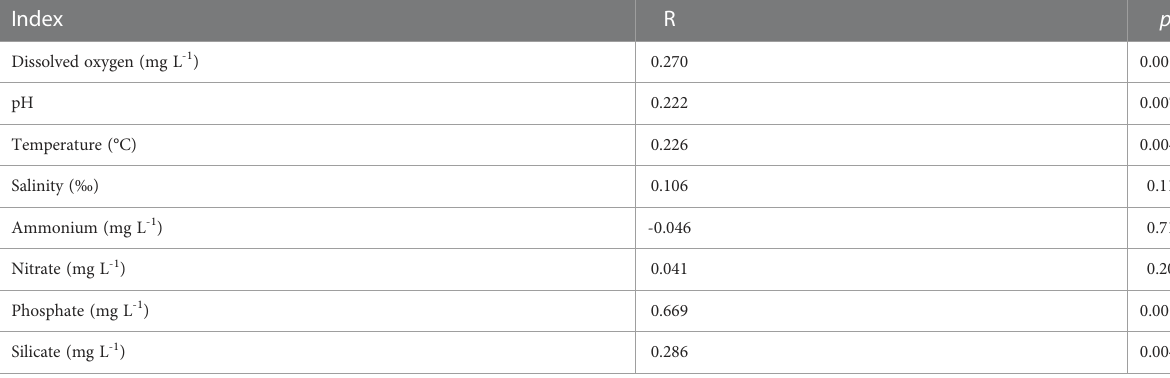
TABLE 2 Spearman ’ s correlations (R values) between transformed environmental variables and water bacterial community compositions as determined via Mantel